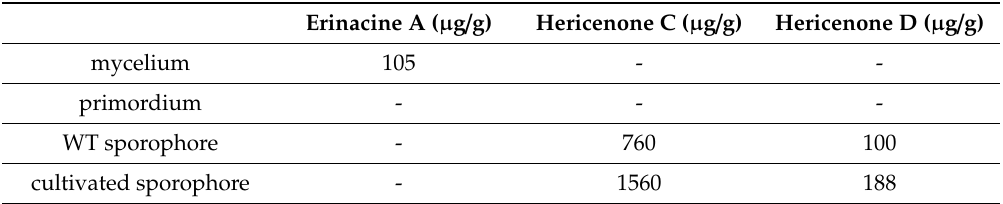
Table 5. Content of erinacine A and hericenones C and D in H.e.2 lyophilized mycelium, fresh primordium and dried sporophores.